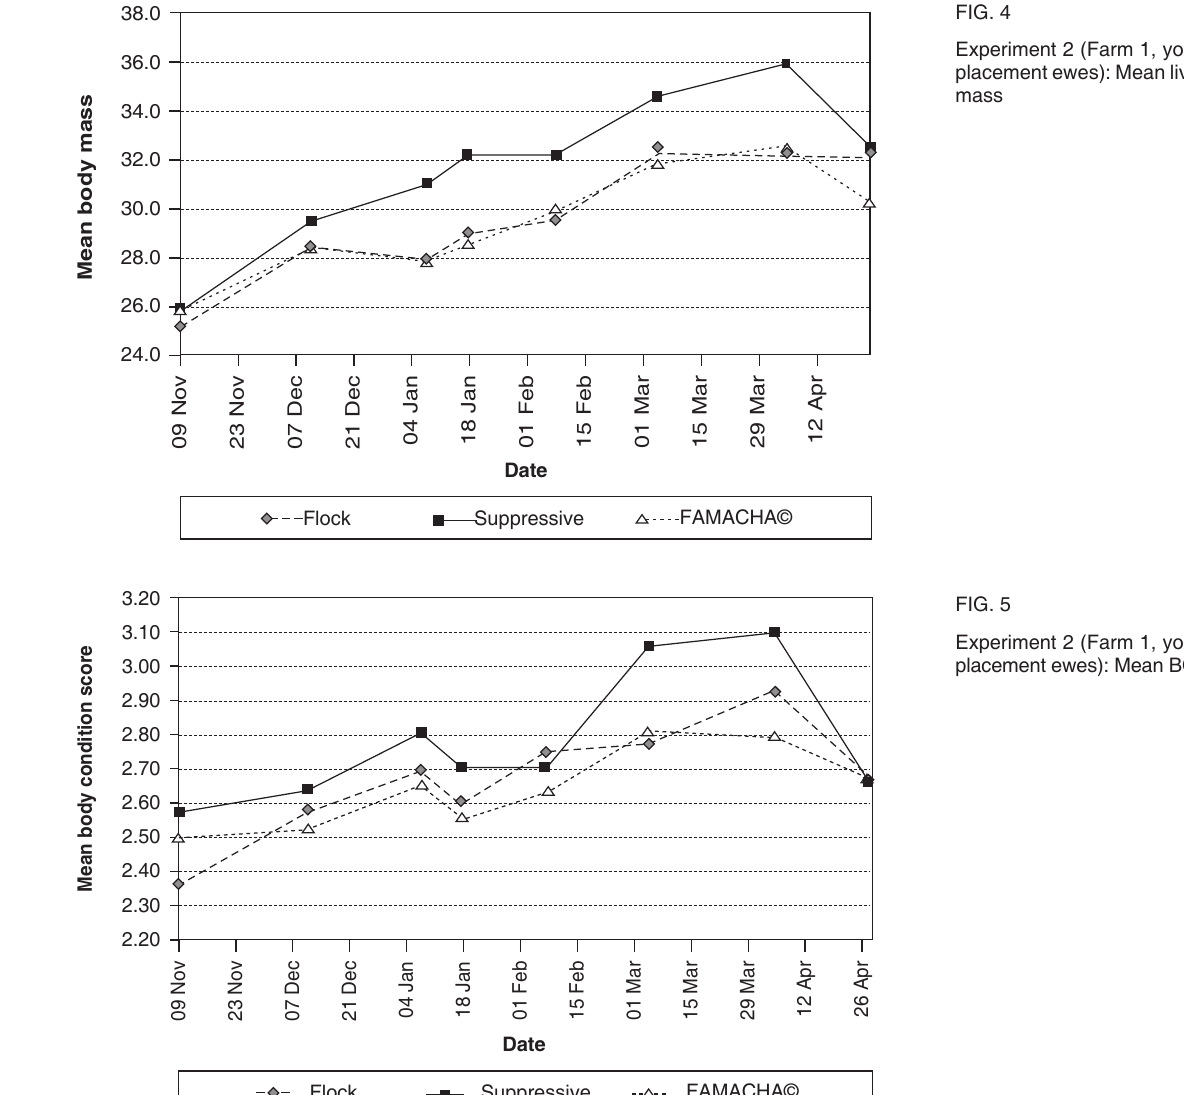
Experiment 2 (Farm 1, young re- placement ewes): Mean